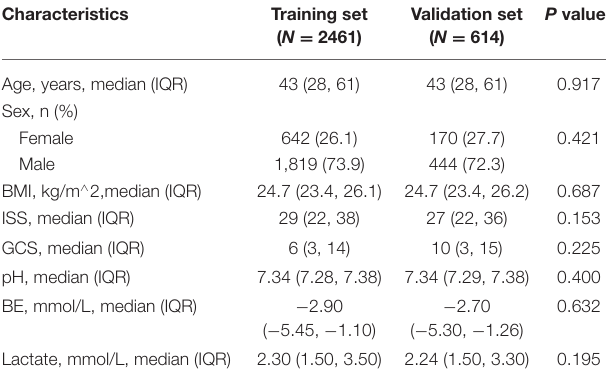
TABLE 1 | Baseline characteristics of the training and validation